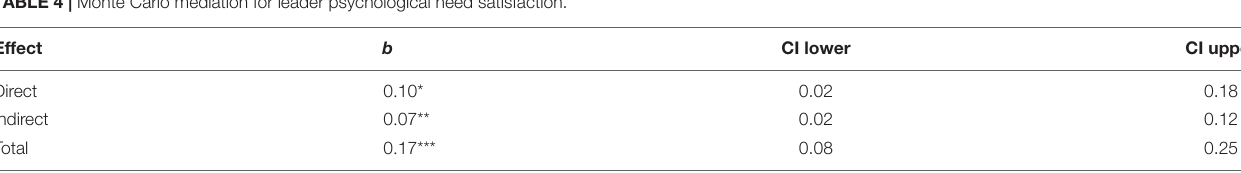
TABLE 4 | Monte Carlo mediation for leader psychological need